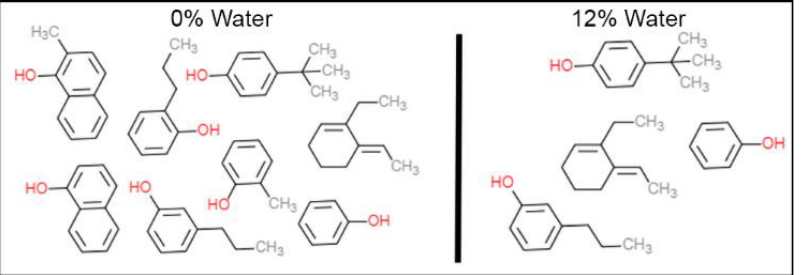
Figure 4. Suggested structures of products observed in the GC-MS analysis of extracts from spent catalysts digested in HF.